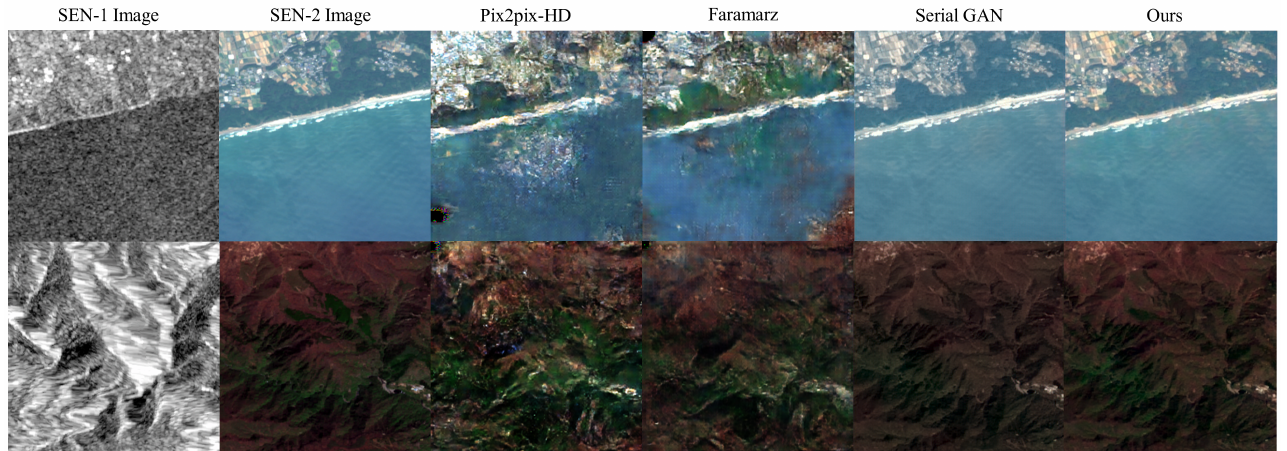
Figure 8. The results of different SAR-to-optical transformation models. The topography shown in the figure from top to bottom is: coastal city, and desert. Best viewed in